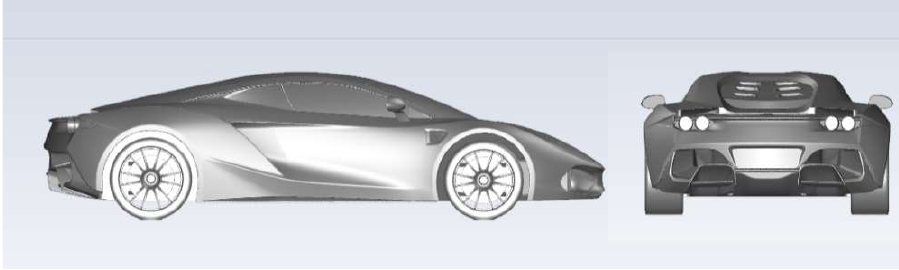
Figure 2. Basic version of supercar geometry.